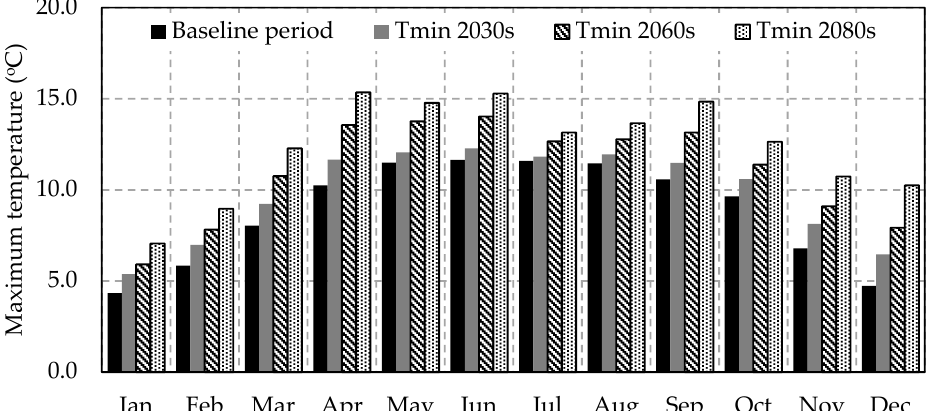
Figure 8. Long-term average monthly minimum temperature for baseline period and future time horizons (2030s, 2060s, and 2080s) in the Main Beles and Gilgel Beles subbasins. The long ‐ term average monthly potential evapotranspiration was estimated for the baseline period and for the projected time horizons using the maximum and minimum temperature (Figure 9). The result indicated that the potential evapotranspiration might increase throughout the coming century. The average monthly potential evapotranspiration may increase by 2%, 4.7%, and 7.8%, in the 2030s, 2060s, and 2080s, respectively. The increasing temperature due to climate change may affect soil water balance by increasing soil evaporation and plant transpiration, thereby affecting crop growth and agricultural productivity [61].